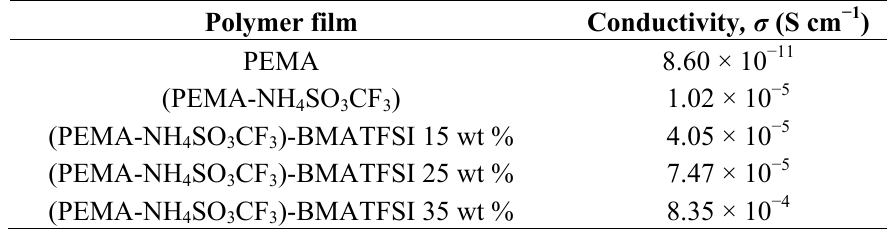
SO CF -BMATFSI polymer electrolyte 4 3 3